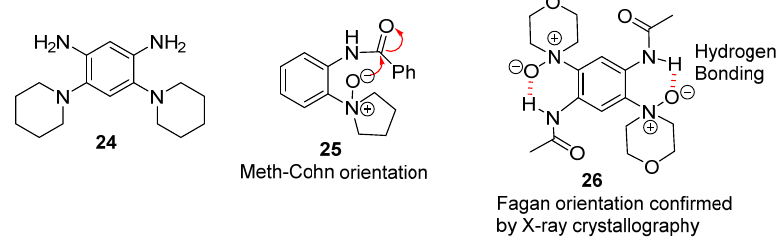
Figure 6. Key chemical structures in resolving the mechanism [27,37,38].